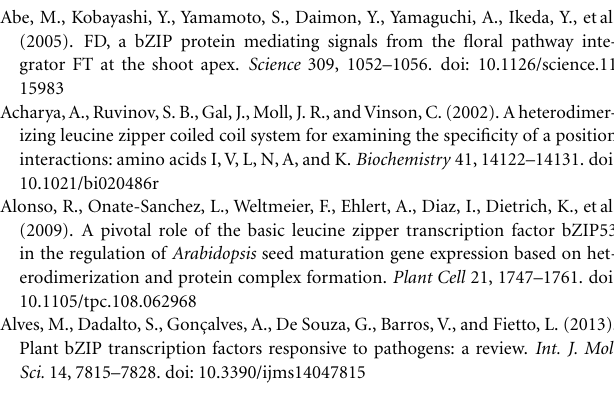
FIGURE 5 | Model featuring the main differences between the regulatory strategies of the two families. (A) The expression of WRKY TFs is strongly regulated at the transcriptional level. The promoters of the WRKY genes are enriched in W-boxes, which are bound by WRKY proteins indicating transcriptional networking and also feed-back regulations. The dotted lines indicate that WRKY possibly interact with the DNA also in a